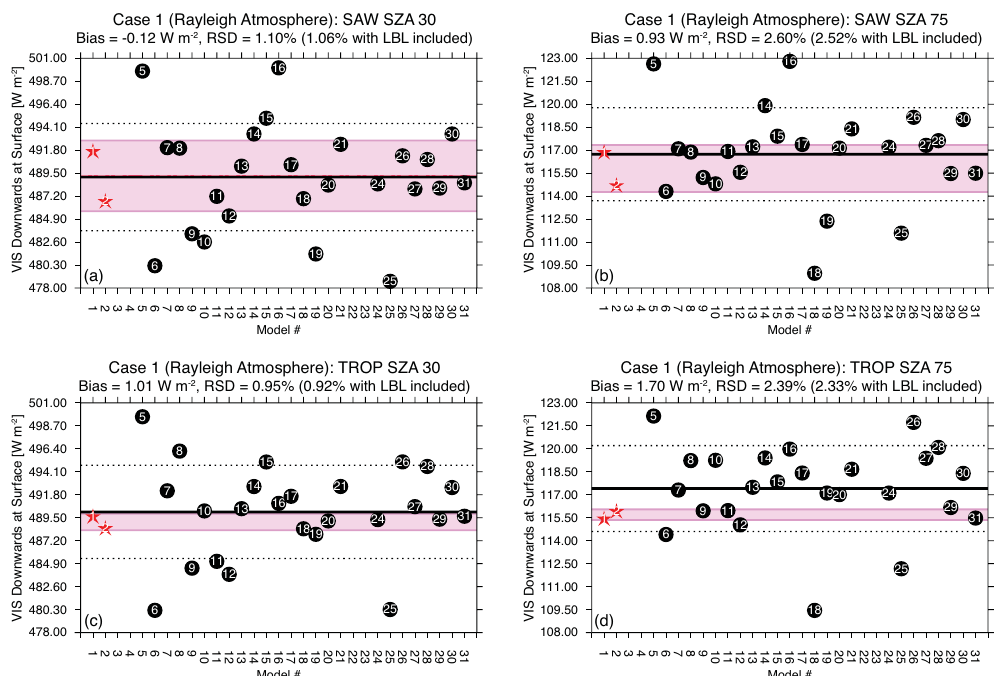
Fig. A2. UV-VIS flux down at the surface in Case 1 (Rayleigh atmosphere) for (a) SAW 30 ◦ , (b) SAW 75 ◦ , (c) TROP 30 ◦ , and (d) TROP 75 ◦ . LBL results are given as stars; non-LBL models are black circles. The pink shading indicates ± 1 standard deviation from the LBL mean. The non-LBL mean is given as the thick black line with ± 1 standard deviation indicated by dotted black lines. The model bias relative to the LBL-mean is given as well as the relative standard deviation (RSD) excluding (and in parenthesis including) the LBL models. See Appendix Table A2 for additional statistics.